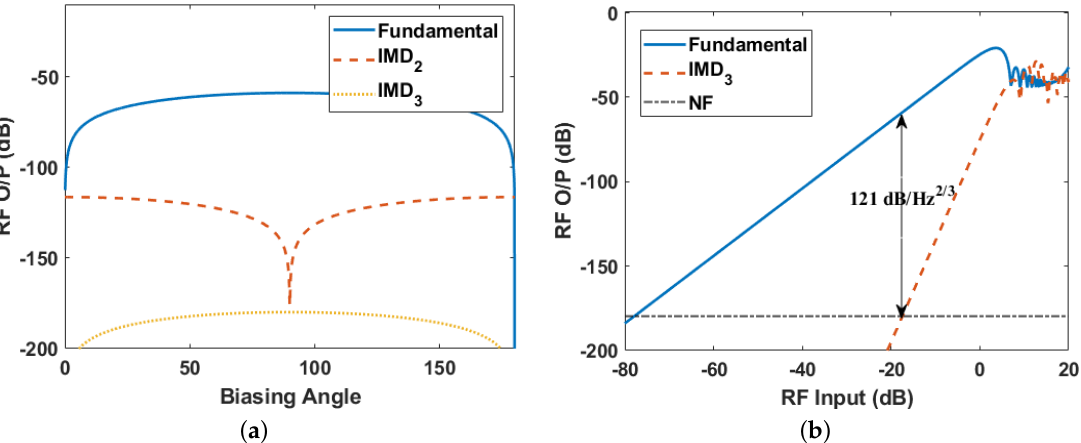
Figure 8. ( a ) Fundamental, IMD2 and IMD3 RF output at the detector versus biasing angle and ( b ) fundamental, IMD3 and noise floor RF output versus RF input